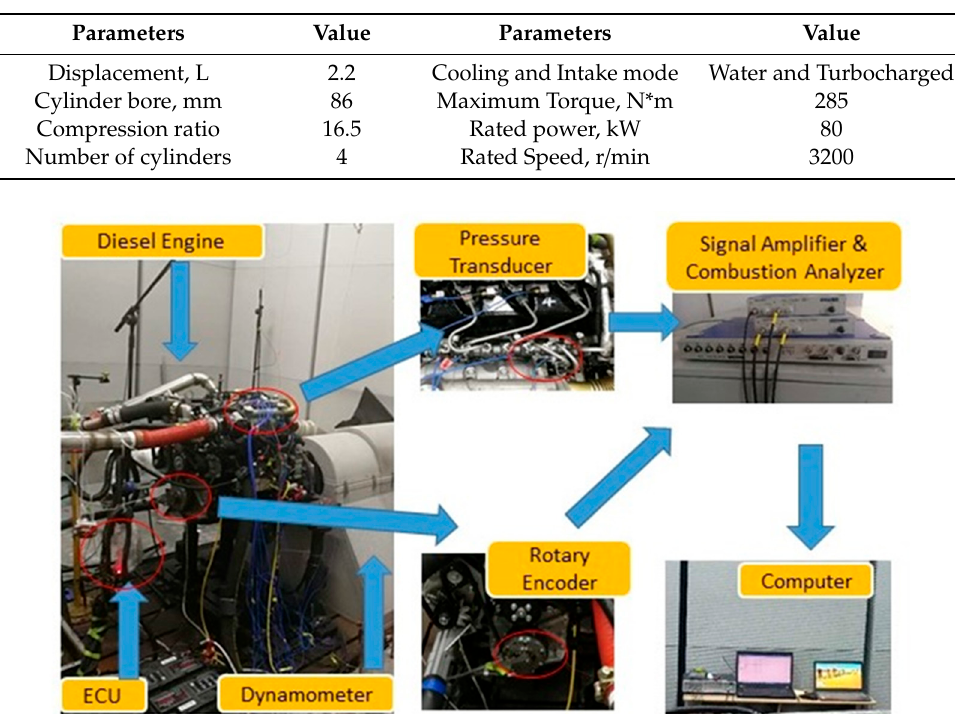
Figure 1. Experimental setup and equipment.